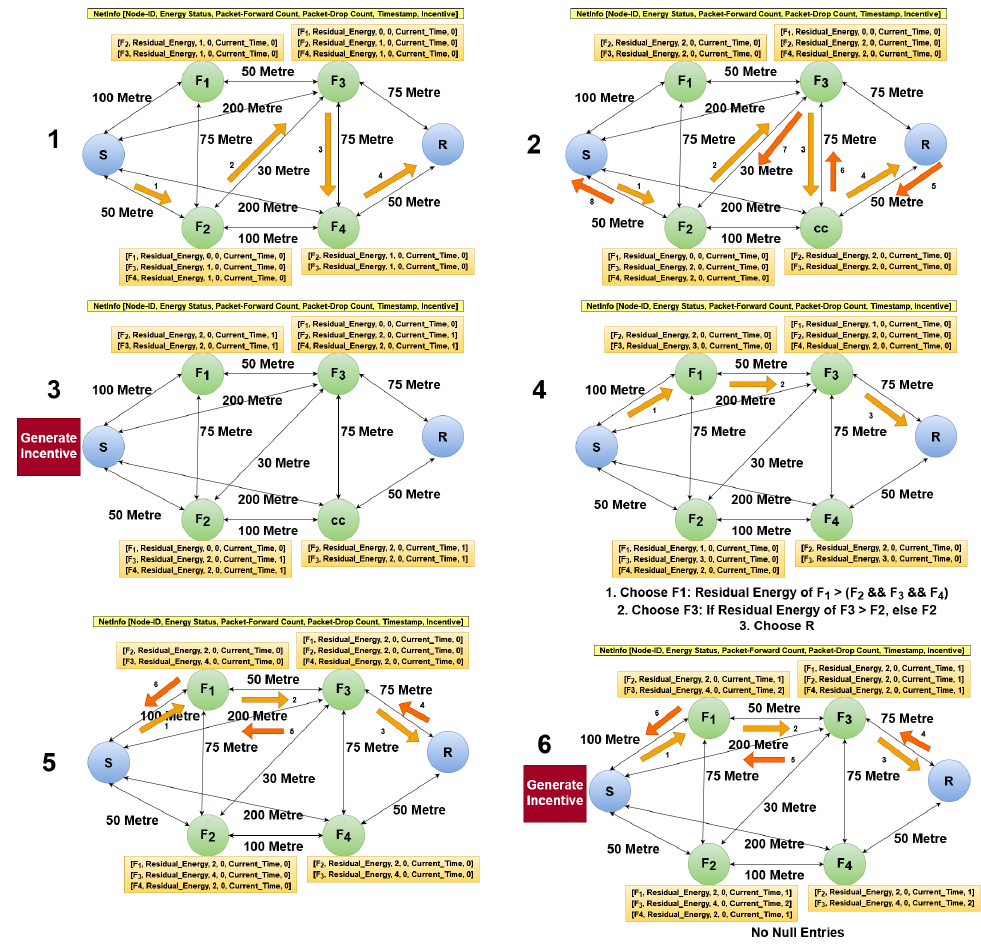
Figure 3. The protocol initially stabilizes the network for proper decision-making in upcoming sessions. ( 1 ) Node S chooses the next hop by considering energy status and distance. ( 2 ) Packet forwarding and returning of ACK packet along the bi-directional route. ( 3 ) S generates incentives for all relay nodes based on NetInfo obtained from direct and overheard nodes. ( 4 ) The F 1 node is chosen as the next hop, as its energy residue is more than the peer nodes of S . ( 5 ) Optimal route selection to reach node R via F 3 . ( 6 ) S generates incentives for all the relay nodes after receiving the ACK/NACK packet via the same